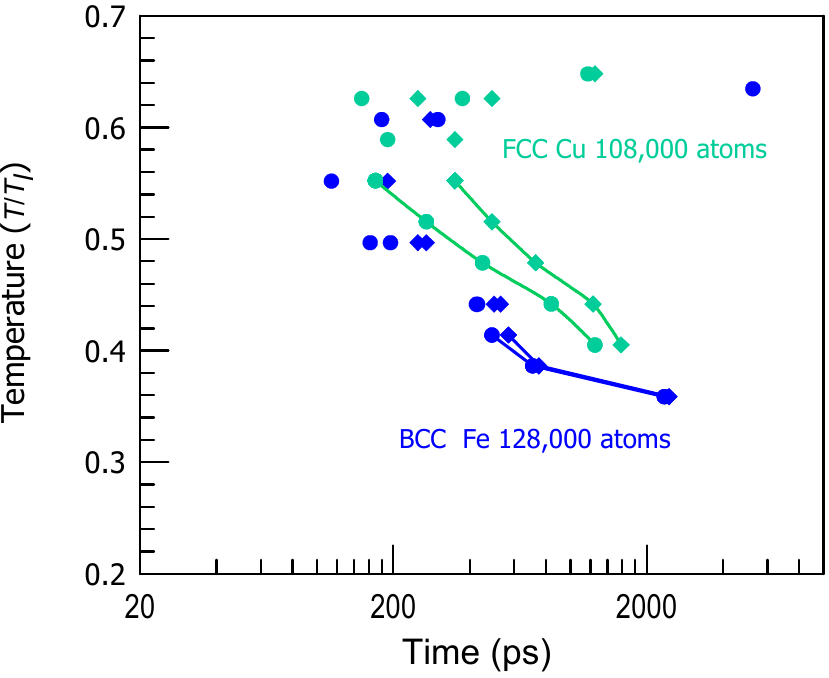
Figure 5. Time-temperature-transformation (TTT) diagram for Fe (blue) and Cu (green). Circles indicate beginning of crystallization while diamonds show end of crystallization.